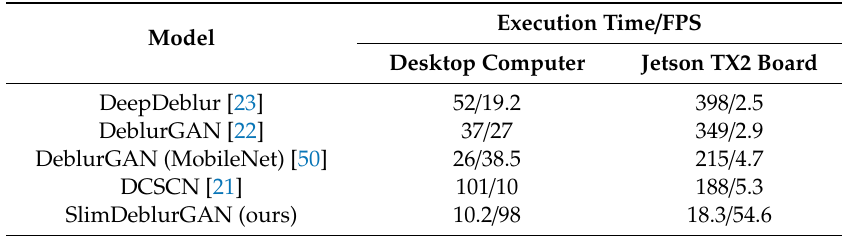
Table 16. Processing time (ms) per image with FPS of motion deblurring networks on two platforms.